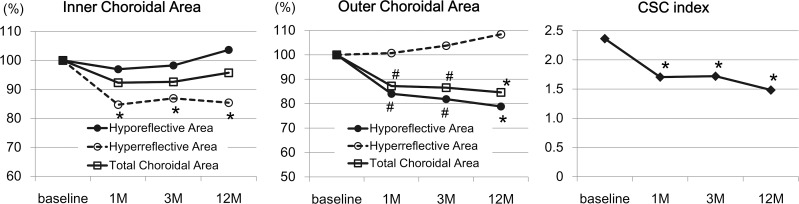
Time course of changes in EDI-OCT parameters in different layers of choroid In the inner choroid, the mean hyperreflective area but not the mean hyporeflective area was significantly decreased at 1 month and thereafter.In the outer choroid, the hyporeflective but not the hyperreflective area was significantly decreased at 1 month and thereafter. The CSC index was significantly decreased at 1 month and thereafter. The values of the choroidal areas are presented relative to that at the baseline. *P <0.001, #P <0.01.